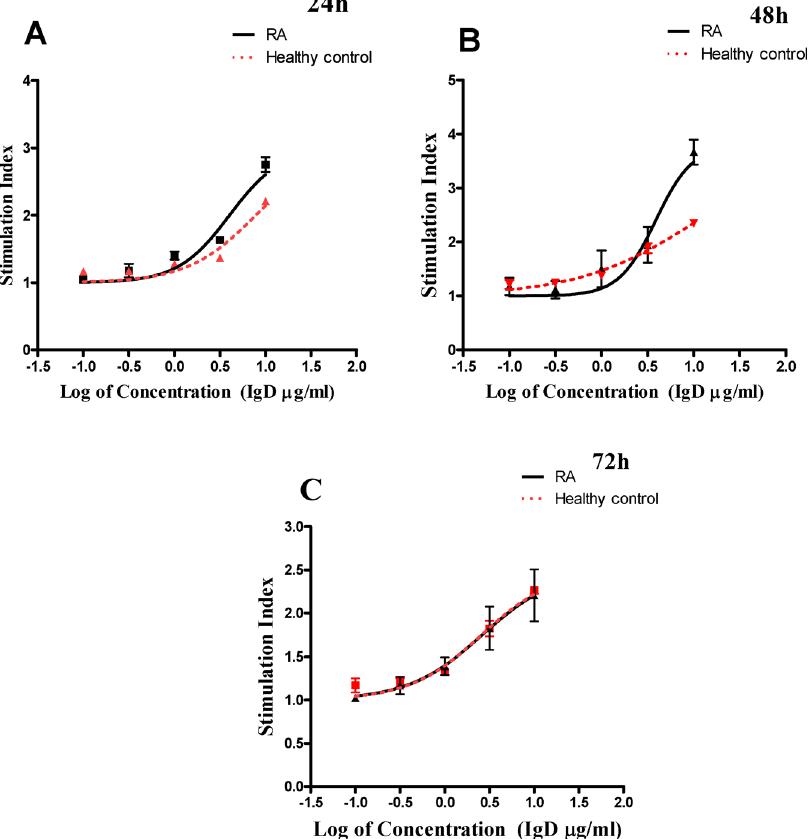
Fig 4. The stimulating effect of IgD on human PBMCs from RA patients and healthy controls. PBMCs from RA patients or healthy controls cultured with 0.1, 0.3, 1, 3, 10 μ g/ml of IgD in duration [24h (A), 48h (B), 72h(C)]. Data was expressed as mean ± standard error of mean (n = 4), SI = absorbance at 450 nm in the cell cultures with drug divided by absorbance in the culture with medium alone.